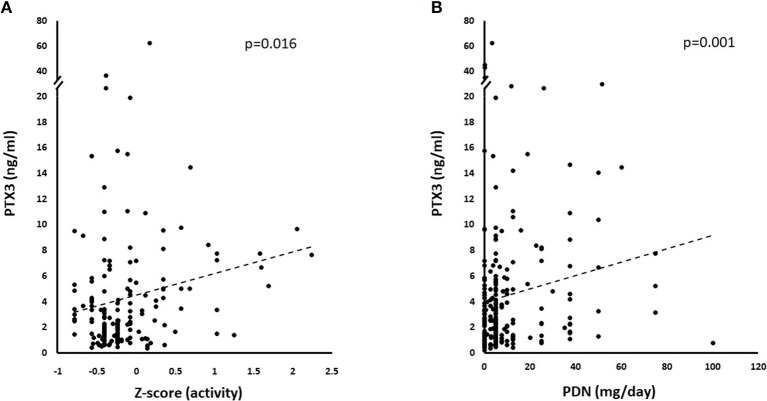
Correlations with PTX3 levels. PTX3 correlated with multiple disease and treatment-related variables at univariate analysis. (A) Depicts the linkage between increasing normalized activity score (Z-activity) and PTX3 plasma levels. (B) Shows the potential influence of corticosteroid treatment on PTX3 circulating levels.